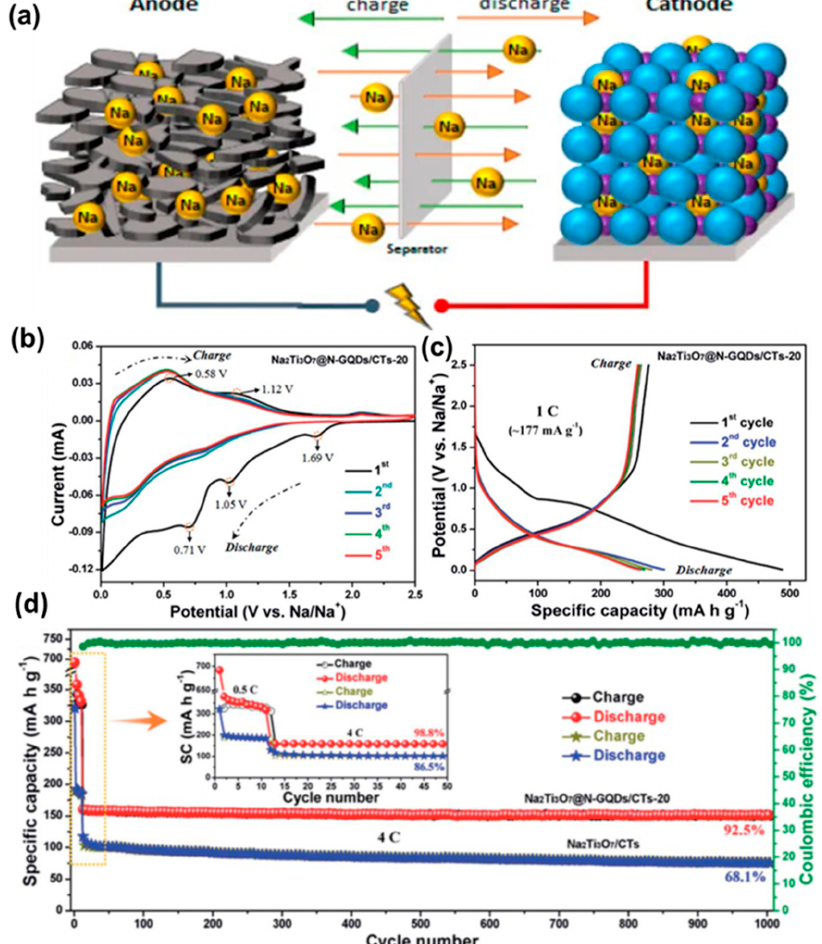
Figure 17. ( a ) Schematic representation of a SIB working principle. Reprinted with permission from Ref. [146]. ( b ) CV curves for the Na 2 Ti 3 O 7 @N-GQDs/CT electrode in different cycles. ( c ) GCD plots at a current density of 1C. ( d ) A comparison between the cycling performances of the Na 2 Ti 3 O 7 @N- GQDs/CT and Na 2 Ti 3 O 7 /CT electrodes. Reprinted with permission from Ref. [148].